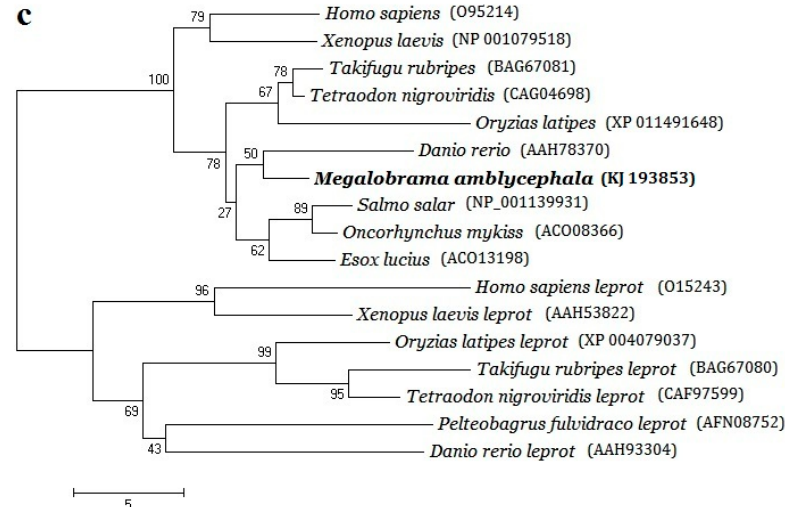
Figure 3 . Phylogenetic tree of M. amblycephala leptin ( a ); leptinR ( b ); and leprotl1 ( c ). Phylogenetic tree was constructed by neighbor-joining method in Clustal X and MEGA 5.0 program by alignment of the ORF encoding peptide sequences of Leptin gene family among M. amblycephala and other organism species. The GenBank accession No. was also showed behind the Latin name of each individual.